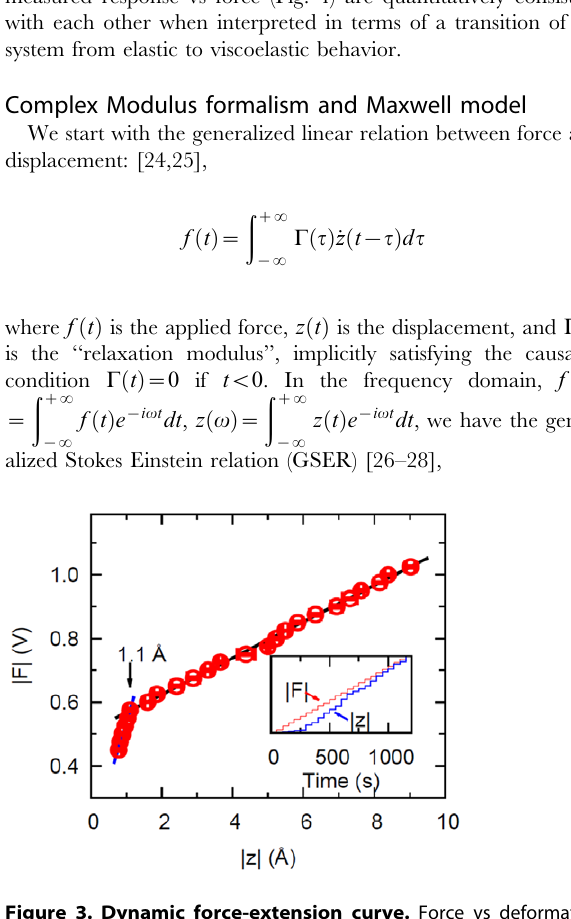
Figure 4. Direct measurement of the storage modulus. Circles: the storage modulus of the folded protein vs applied force measured directly at 10 Hz. Triangles: the storage modulus calculated indirectly from the magnitude of the complex modulus (i.e. from the data shown in Fig. 2b and using eq. (18)). Inset: the ratio ( & 1 ) of the two modulii vs driving force. The error bars for G 0 v ð Þ represent the standard deviation of 5 measurements.